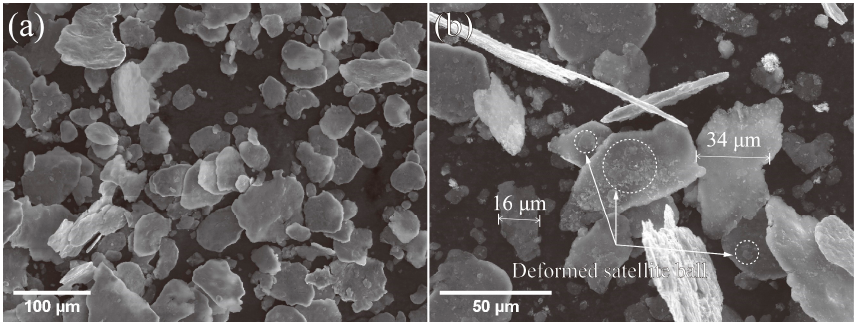
Figure 7. SEM image of #1 GNSs/Al composite powders ( a ) and magnified SEM image ( b ).